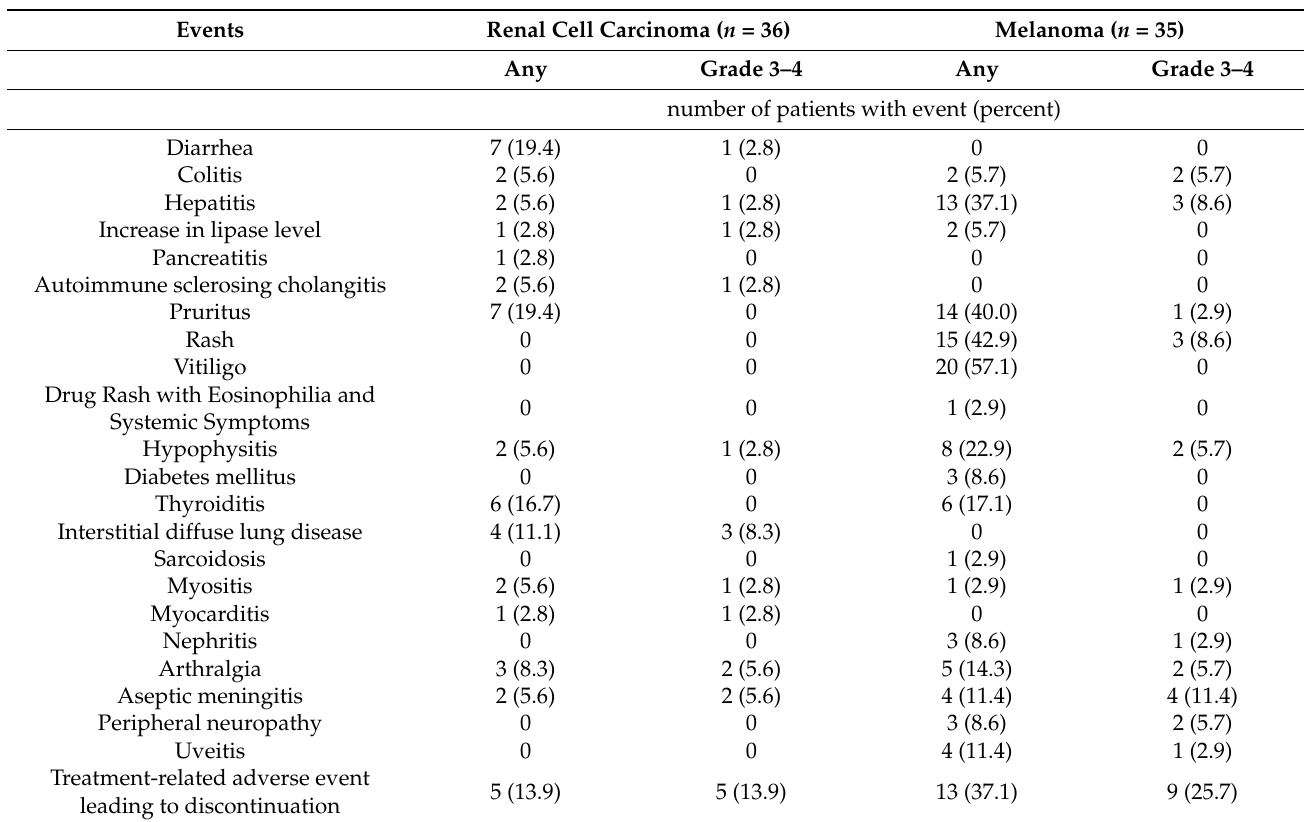
Table 4. Adverse events in patients with advanced renal cell carcinoma and melanoma treated with ipilimumab plus